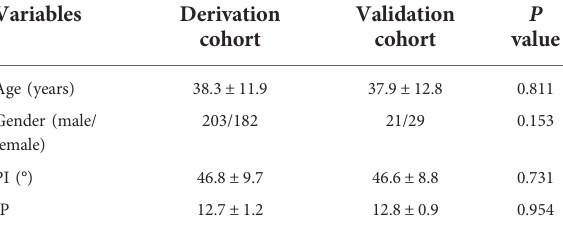
TABLE 6 Baseline characteristics of the 2 cohorts.